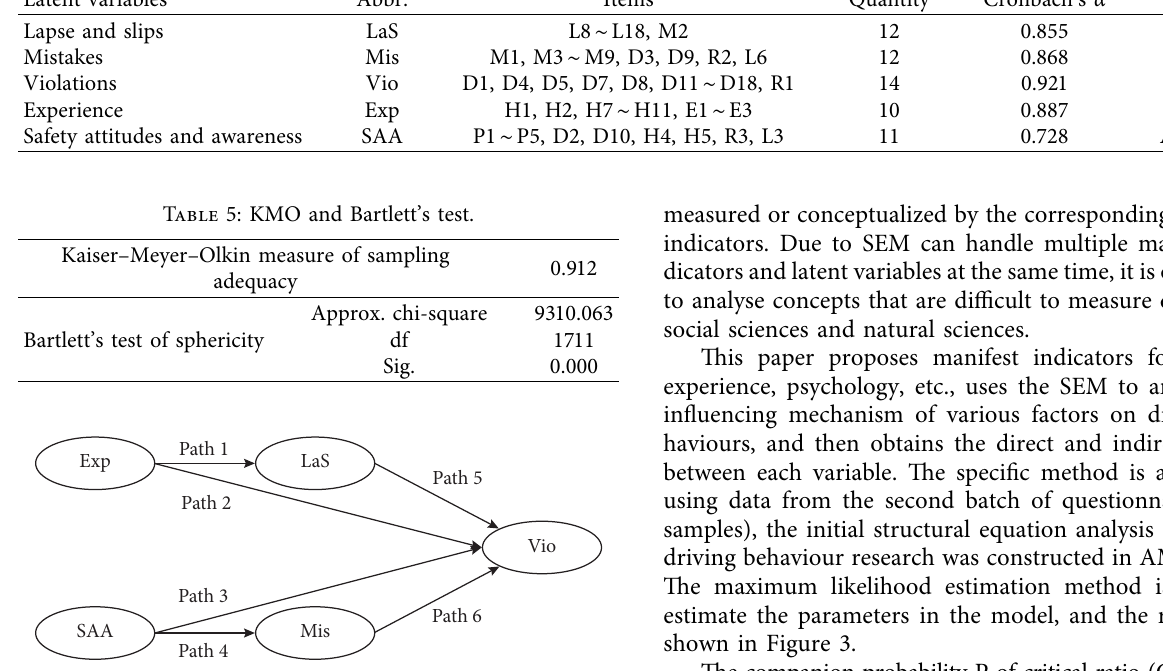
Figure 2: A hypothesis conceptual model of driving behaviours.